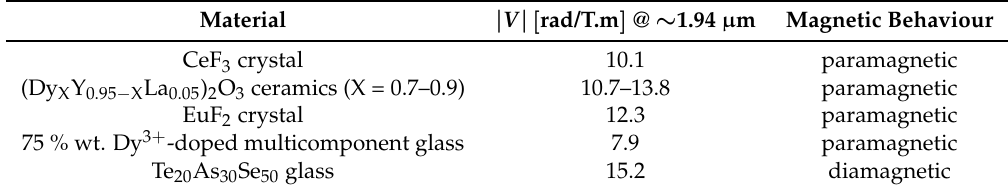
Table 1. The yet-reported paramagnetic or diamagnetic mid-IR magneto-active materials and the absolute values of their Verdet constant at ∼ 1.94 µ m